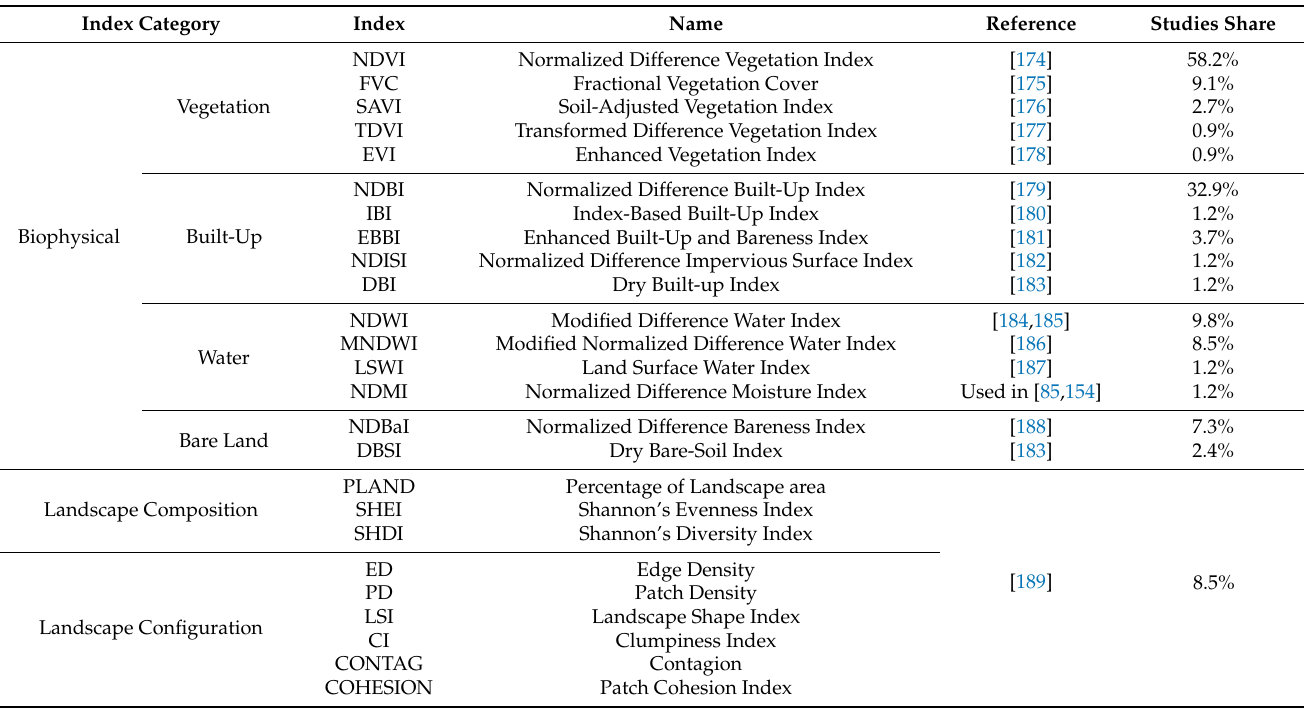
Table A2. List of the most common indices employed in the reviewed